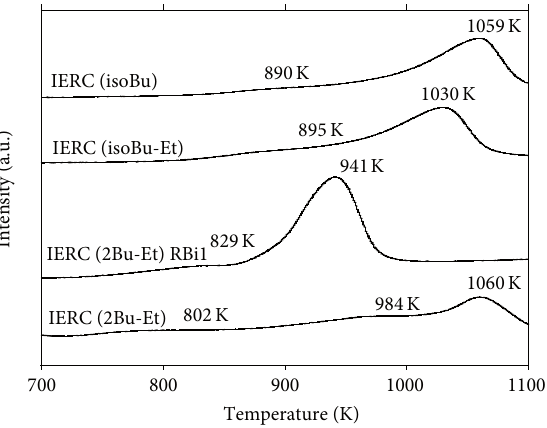
F 6: e relation between conversion ( and MA yield ( ) of catalysts produced in n -butane %